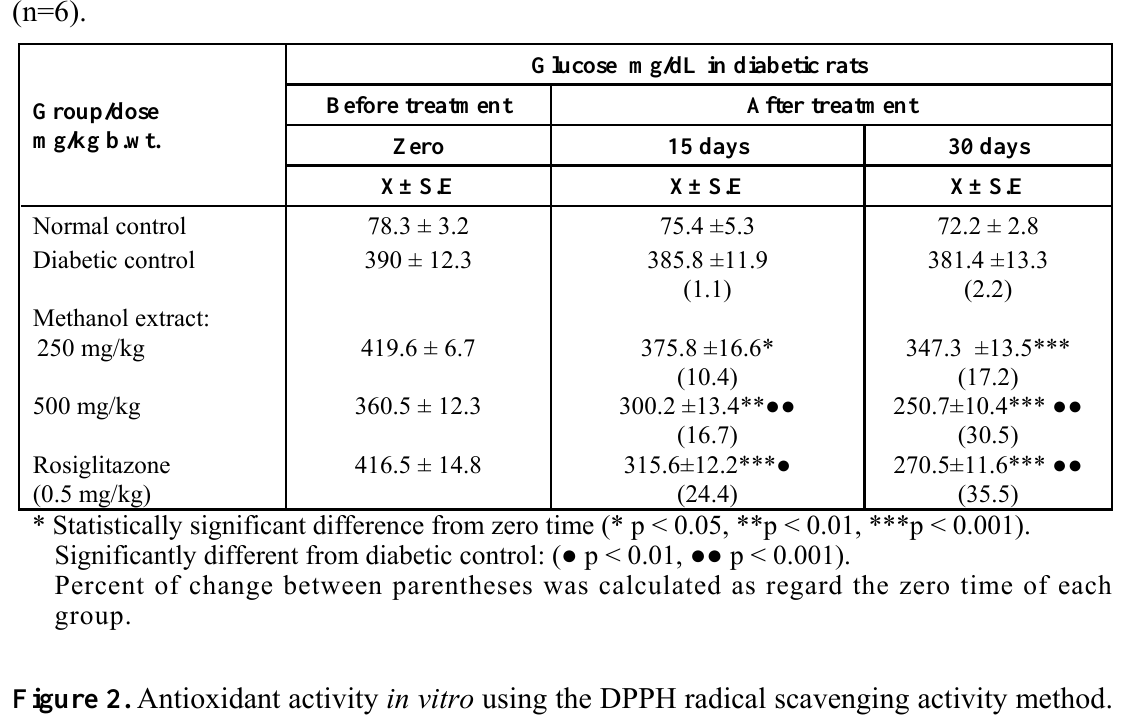
Figure 2. Antioxidant activity in vitro using the DPPH radical scavenging activity method. (a) Antioxidant activity of 80 % aqueous methanol extract of O. speciosa and